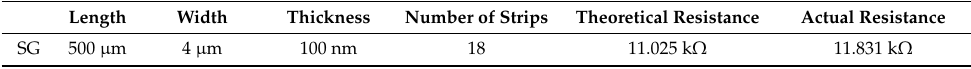
Figure 2. Circuit diagram of stretchable wire and strain gauge. Table 1. Geometric Parameters and Resistance Values of Microfabricated Strain Gauges (SG).